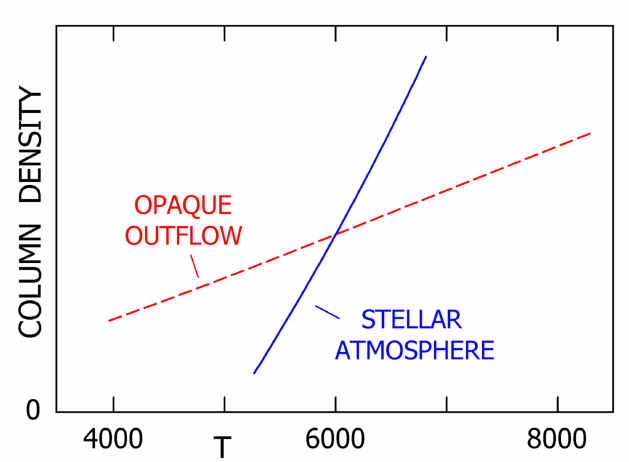
Figure 7. Sketch of the mass column density at temperatures below T , in a stellar atmosphere and in a dense outflow. These curves are based merely on idealized textbook-style models of ρ ( r ) and T ( r ) , but the difference between them is qualitatively